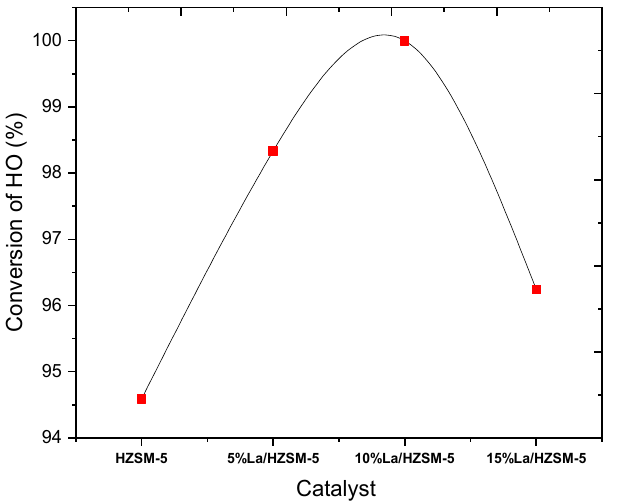
the parent HZSM-5. The conversion percentages of the algal HO were 98.333%, 100%, and 96.242% for the liquid product of the catalytic deoxygenation over 5% La/HZSM-5, 10% La/HZSM-5, and 15% La/HZSM-5, respectively. In conclusion, the loading of lanthanum into HZSM-5 zeolite with different loading percentages enhanced the acid sites needed to improve the algal HO conversion.